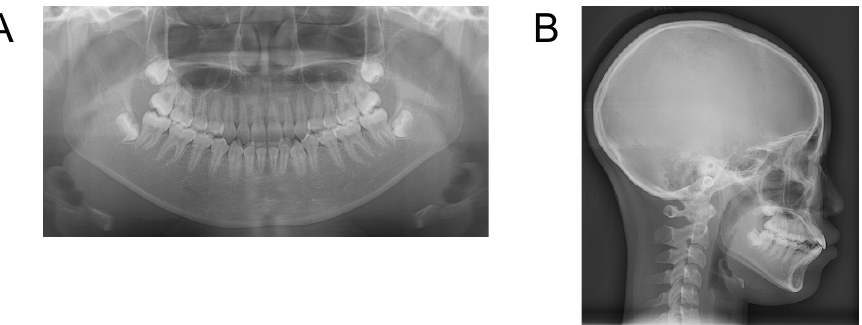
Figure 15. Facial photograph and intra-oral photograph of Case 3 at the end of the first stage of treatment. Facial photograph and enlarged photograph of the mouth at the end of the first stage of treatment ( A ); intra-oral photograph at the end of the first stage of treatment ( B ).